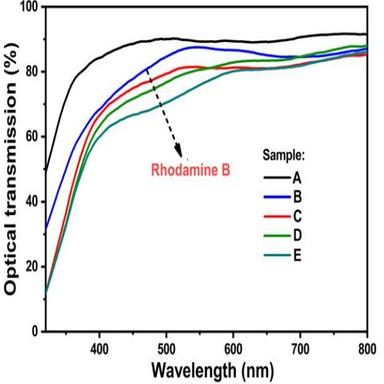
Optical transmission of PMMA pure and doped with Tb(tmhd)3 and RhB. The concentrations of samples A to E are in